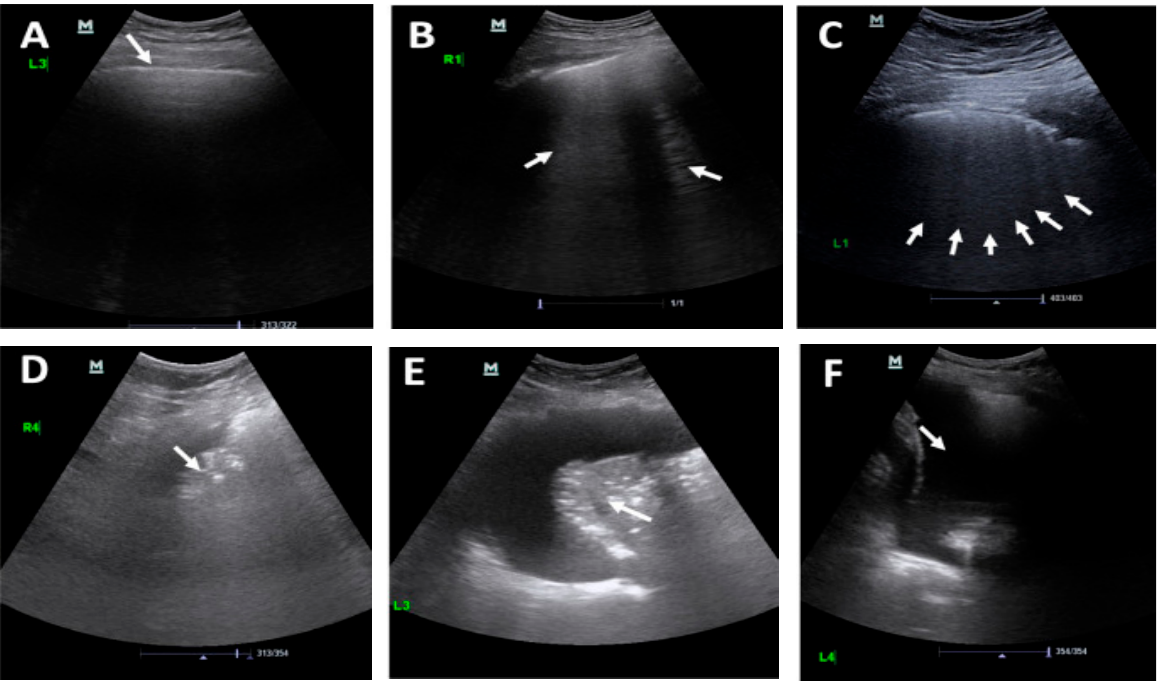
Figure 6. ( A – F ) subfigures show the progression of a US image for a COVID-19 patient across days (1, 3, 6, 7, 8, and 10, respectively). The white arrows in each subfigure clarify the change in each day.